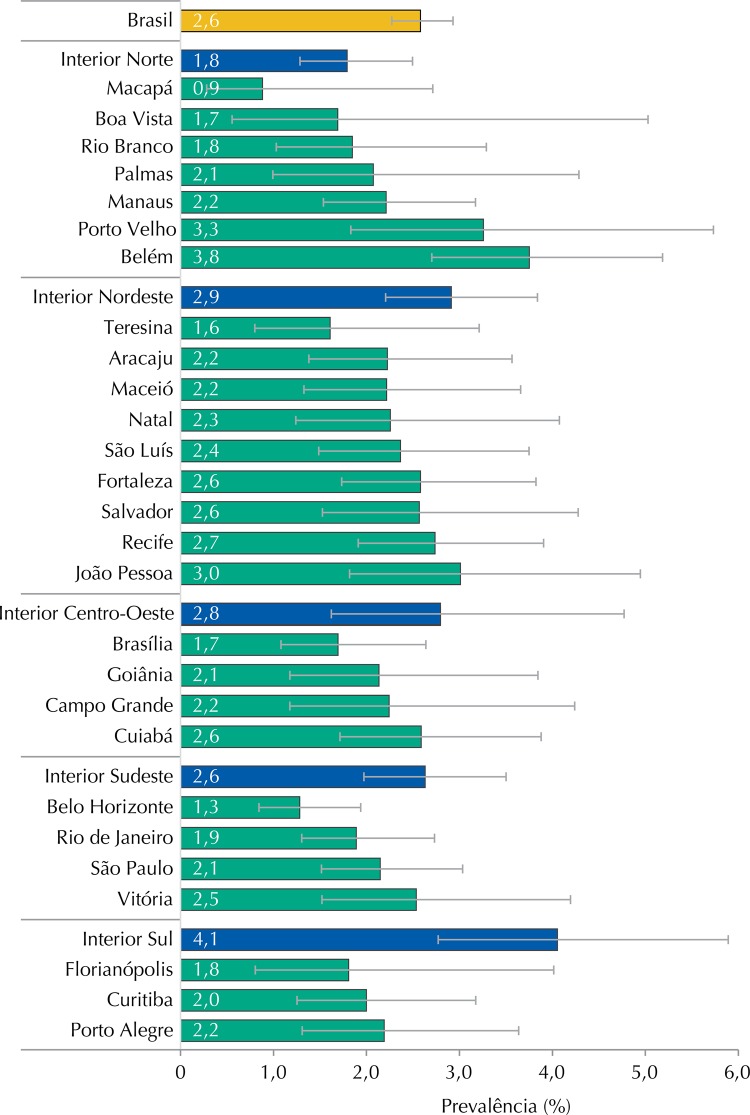
Prevalências (%) e IC95% de síndrome metabólica nos adolescentes, segundo estratos de capitais e do interior das regiões. ERICA, Brasil, 2013-2014.